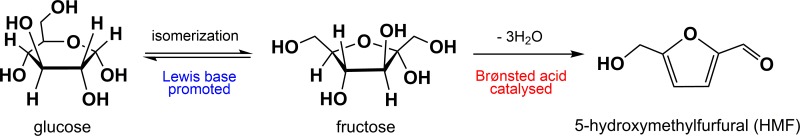
Glucose conversion to 5-hydroxymethylfurfural (HMF).